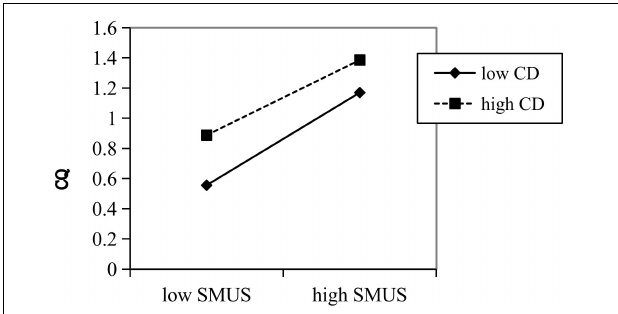
FIGURE 3 | Moderating effect of cultural distance on the relationship between informational social media usage and cultural intelligence.